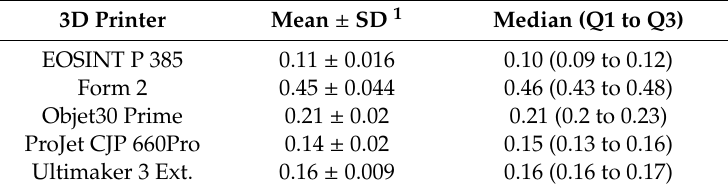
Table 5. Summary of the trueness RMS values (mm) for each 3D printer type.